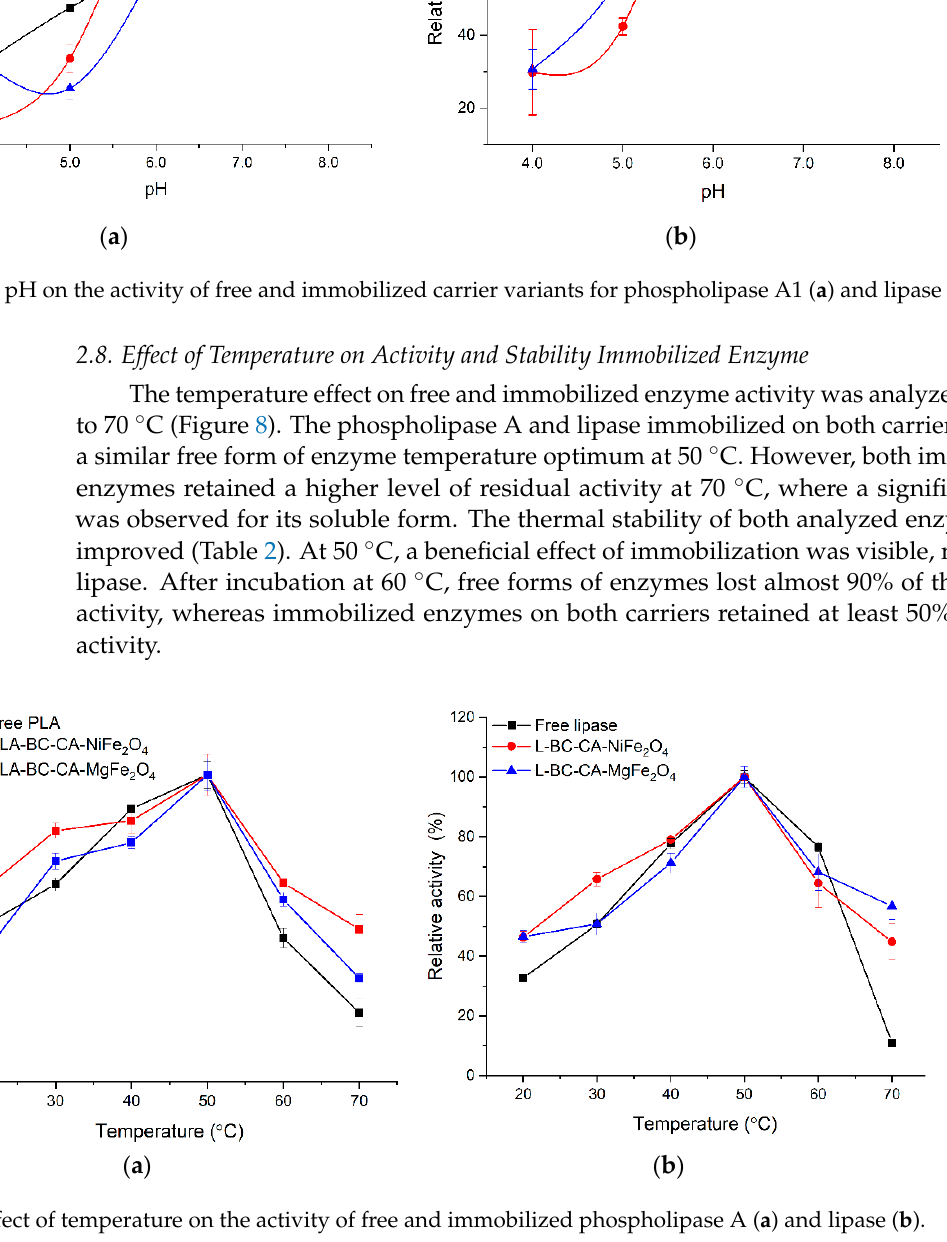
Figure 7. Effect of pH on the activity of free and immobilized carrier variants for phospholipase A1 ( a ) and lipase ( b ).